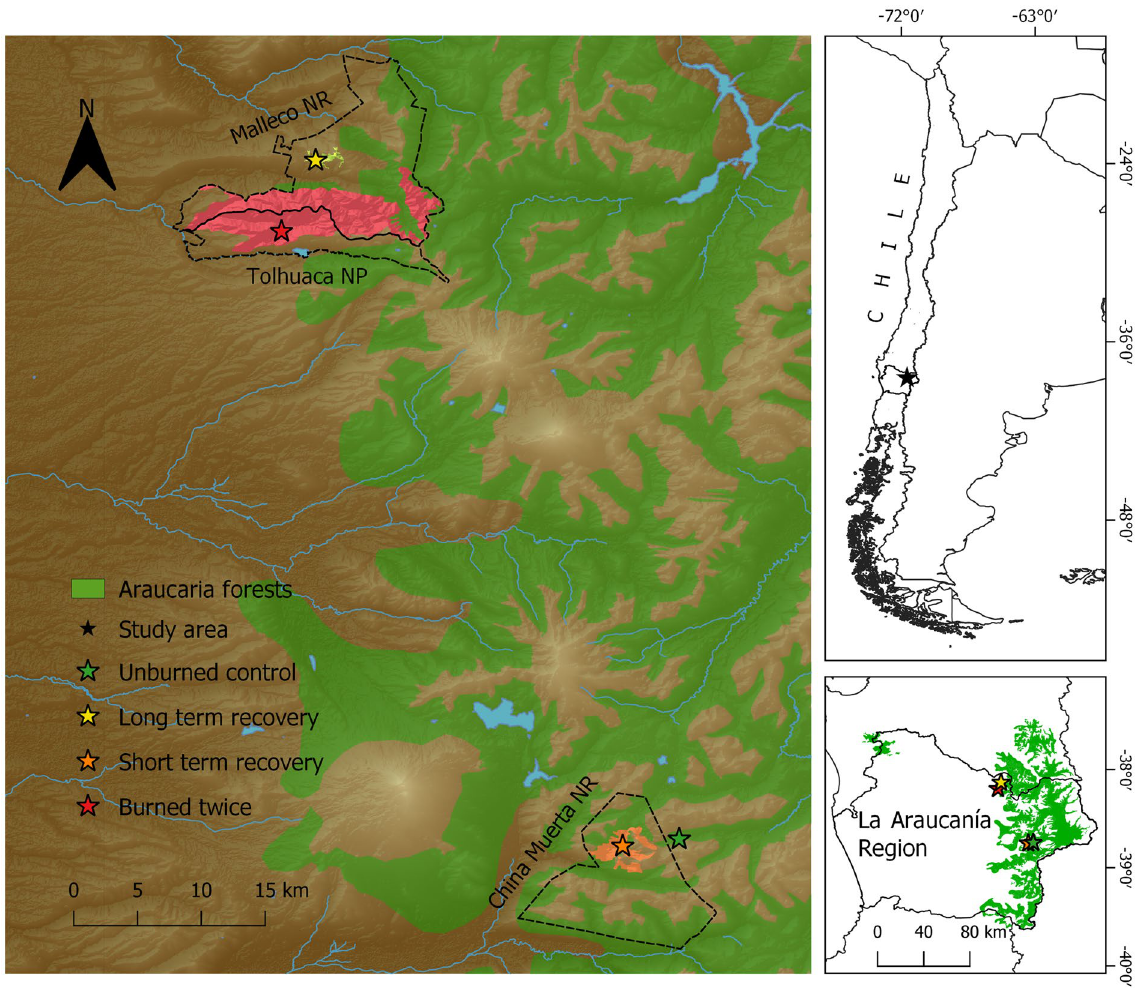
Figure 3. Study area map, located in the Araucarias Biosphere Reserve (ABR) in the Andes of La Araucanía Region, Chile. Fire “treatments” are shown in red, orange, yellow and green colors. We also show the approximate extent of araucaria forests affected by fires around our sampling areas. Green area shows Araucaria Araucana distribution in Chile 66 . Brown shading represents elevation, with higher elevations in lighter brown, and ranging from approximately 400 to 3000 m.a.s.l. All treatments were located between 1014 and 1469 m.a.s.l. Protected areas are delimited by dashed black